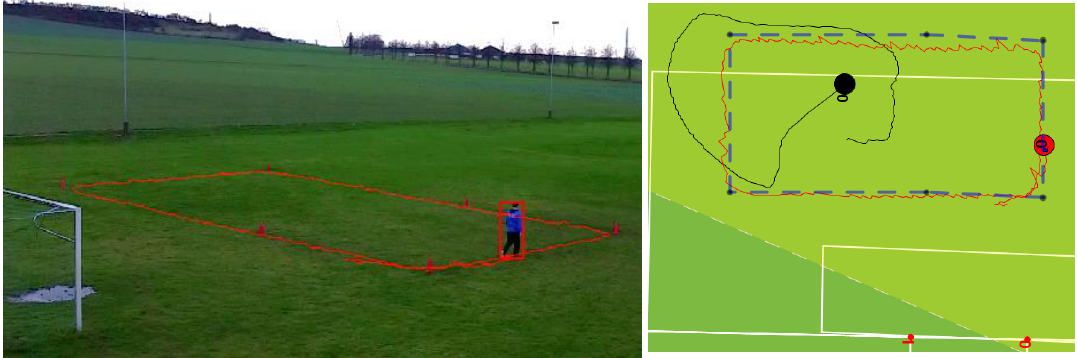
Figure 8. The resulting trajectories of the accuracy experiment: GPS (black) and result of our approach (red). The dots are the object current position determined by GPS (black) and our approach (red). The ground truth polygon is marked by a dashed blue